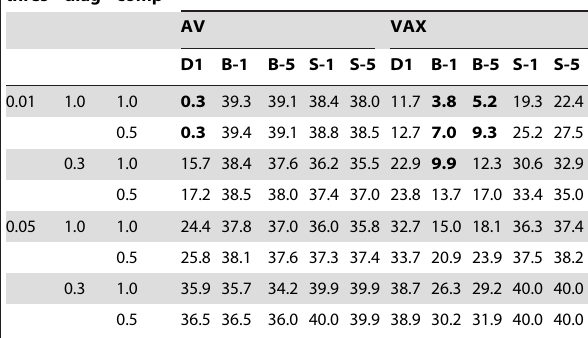
Table 2. High transmissibility 7.35 6 10 2 5